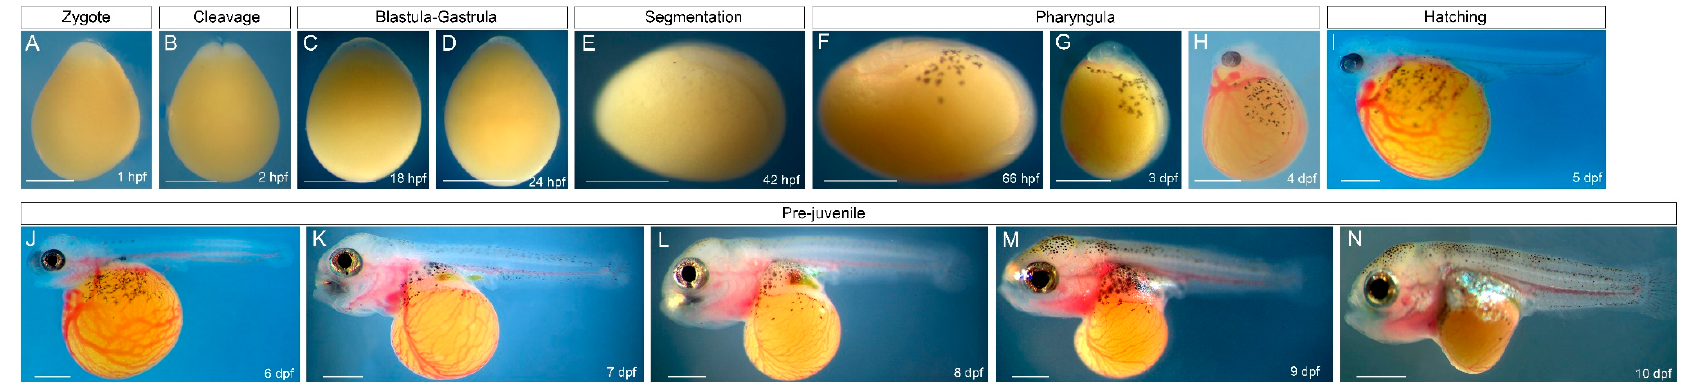
Figure 1. Embryonic and pre-juvenile development of Oreochromis (Alcolapia) alcalica . ( A ) At 1 h post fertilisation (hpf), O. alcalica embryos were ovoid in shape with the embryonic region located at the animal pole, on top of the large yellow yolk. ( B ) At 2 hpf, the first cell division occurred and two blastomeres were observed. ( C , D ) The embryo underwent gastrulation (18 hpf–24 hpf). The cellular dynamics of O. alcalica gastrulation were not easily observed due to the large yellow yolk. ( E ) Gastrulation was completed by 42 hpf. The antero-posterior axis could be distinguished, and the neural tube formed. ( F ) At 66 hpf, the antero-posterior axis elongated further. Pigmented melanocytes of the neural crest lineage emerged from the embryonic axis. A clear head and unpigmented eye could be distinguished. ( G ) By 3 days post fertilisation (dpf), there was an increased number of melanocytes migrating on the yolk. The embryo began to vascularise in patches on the yolk and in the area of the beating heart. ( H ) At 4 dpf, the vascular system extended across the yolk and a clearly beating heart was visible with strong blood circulation. The eye developed pigmentation. ( A – H ) Throughout these stages, the embryo was surrounded by the chorion membrane. ( I ) At 5 dpf, embryos hatched from the chorion. ( J – N ) Following hatching at 6–10 dpf, the yolk decreased in size and embryos rapidly developed adult morphology. ( A – D ) Animal pole to the top. ( E , F , I – N ) Lateral views; anterior to the left. ( G , H ) Lateral views; anterior to the top. Scale bars correspond to 1 mm. Heart contraction was observed and recorded at 66 hpf, 3 dpf, 4 dpf, and 5 dpf (see Supplementary Movies A–D).